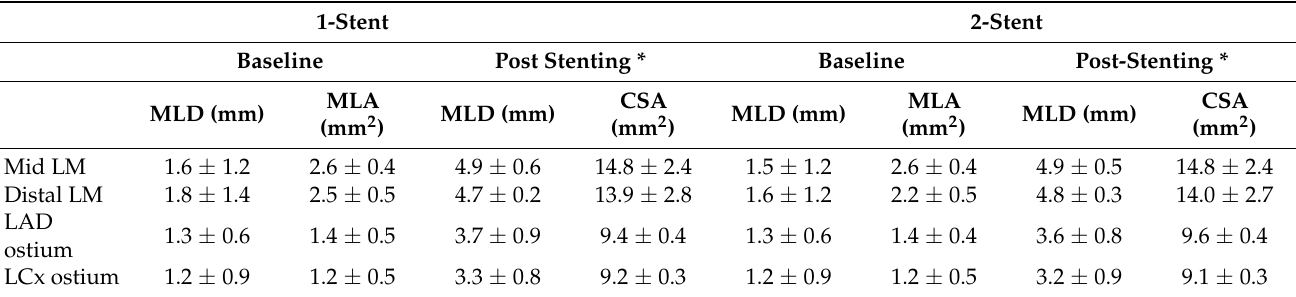
Table 4. IVUS measurements in IVUS assessed